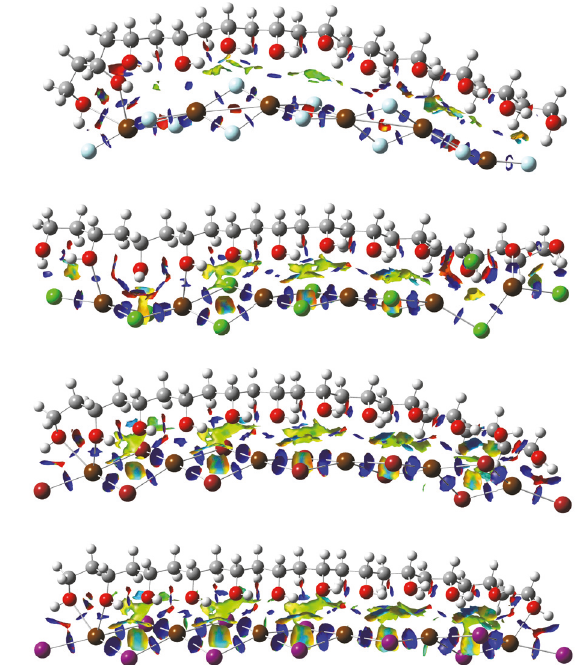
Figure 2: Plots of the NCI isosurfaces ( s = 0.5 a.u. and a blue-green- red color scale from − 0.01a.u. < sign (𝜆 2 )𝜌(𝑟) < +0.01a.u.) for [1 PVA ⋅ n BaHal 2 ]. White: hydrogen, grey: carbon, red: oxygen, dark brown: barium, light blue: fluorine, green: chlorine, light brown: bromine, and purple: